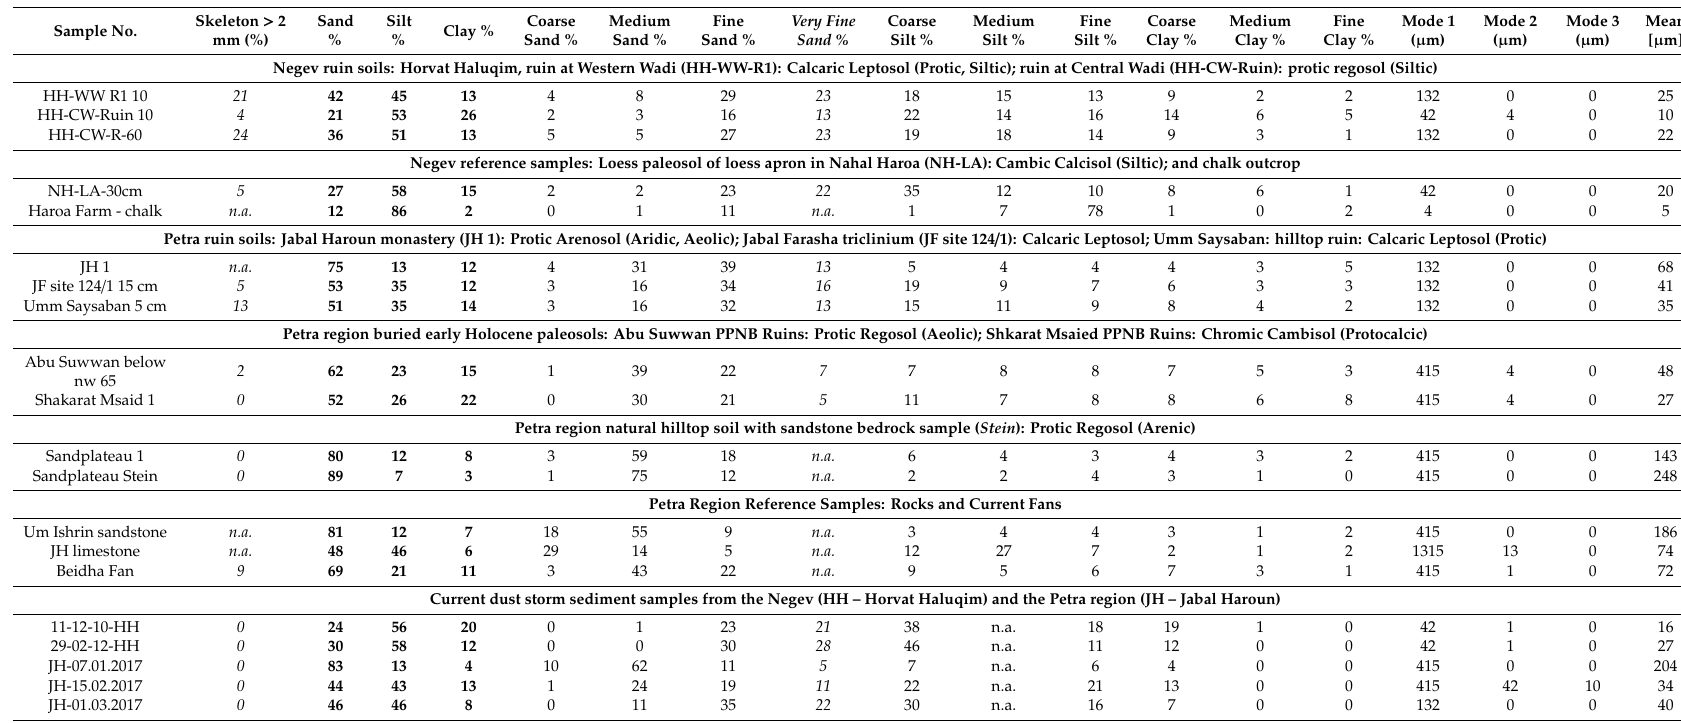
Table 5. Selected results of particle size analysis, including some statistical parameters calculated with the Gradistat program. Note that the very fine sand is part of the fine sand fraction. Note that the very fine sand (in italics) is part of the fine sand fraction. Skeleton is shown as well (in italics), and summarizing grain size units (in bold). Medium silt was not calculated from laser data. Full results: See Tables A2–A4 in Appendix C. Sample No.